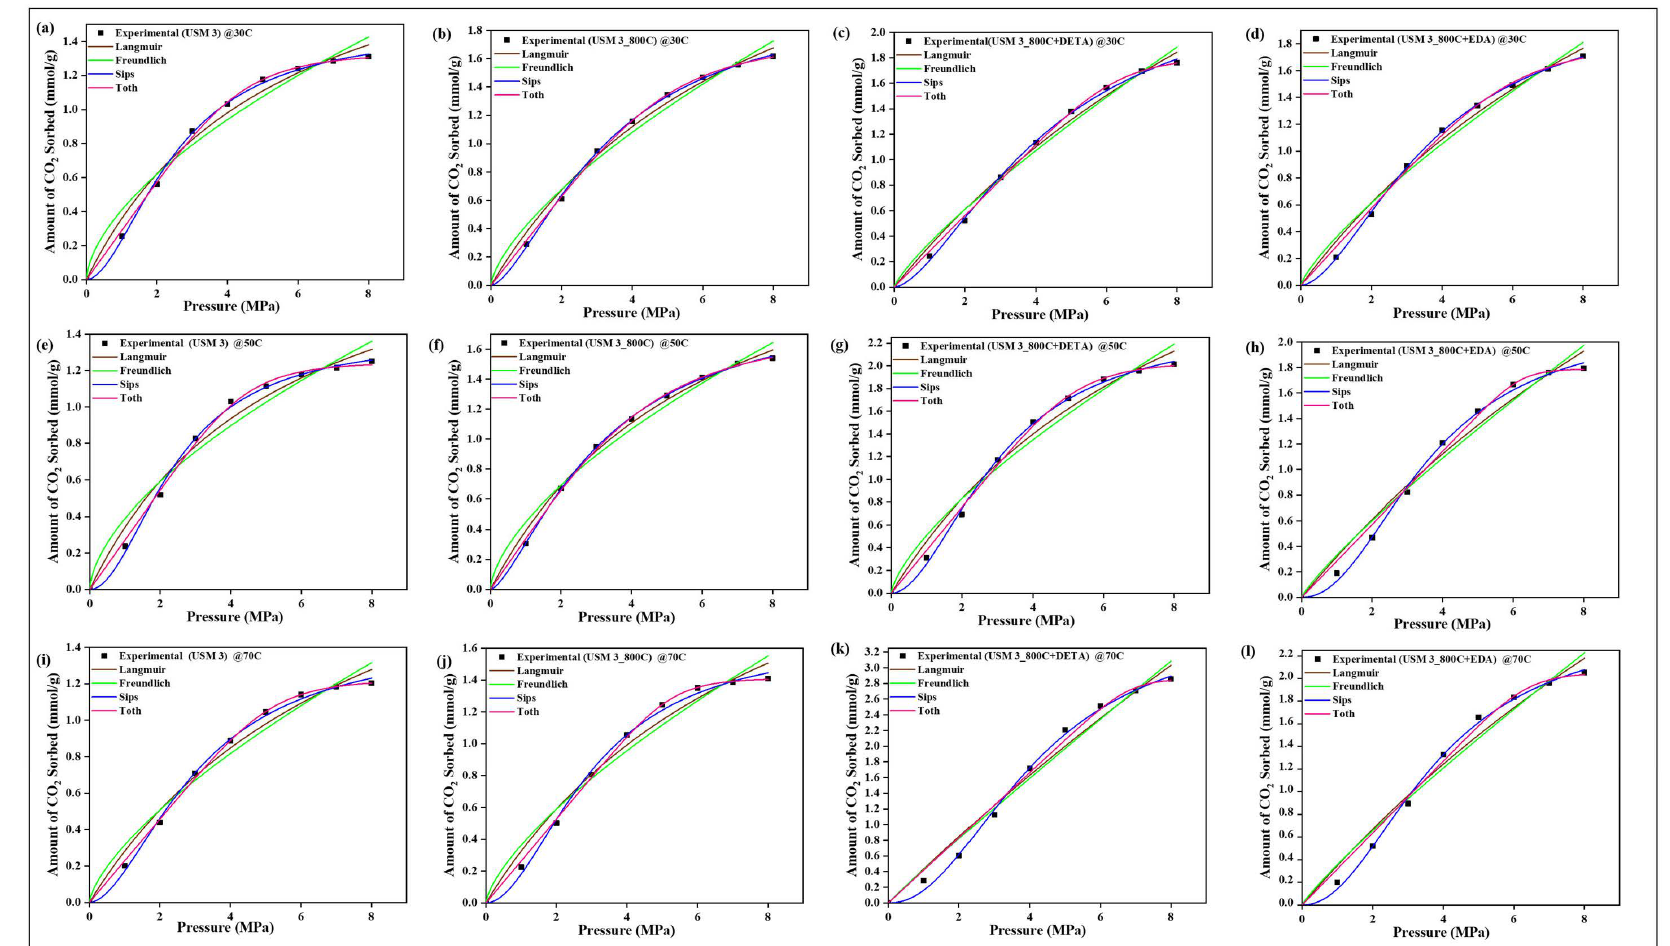
Figure 11. Prediction of the sorption behavior of USM 3 variants with Isotherm models at temperatures 30 ◦ C ( a – d ), 50 ◦ C ( e – h ), 70 ◦ C ( i – l ), and up to 8 MPa